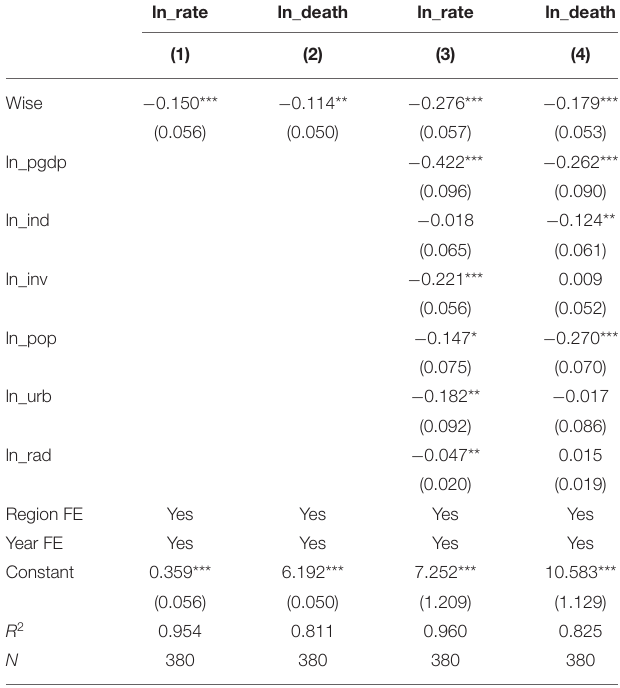
TABLE 3 | Baseline regression